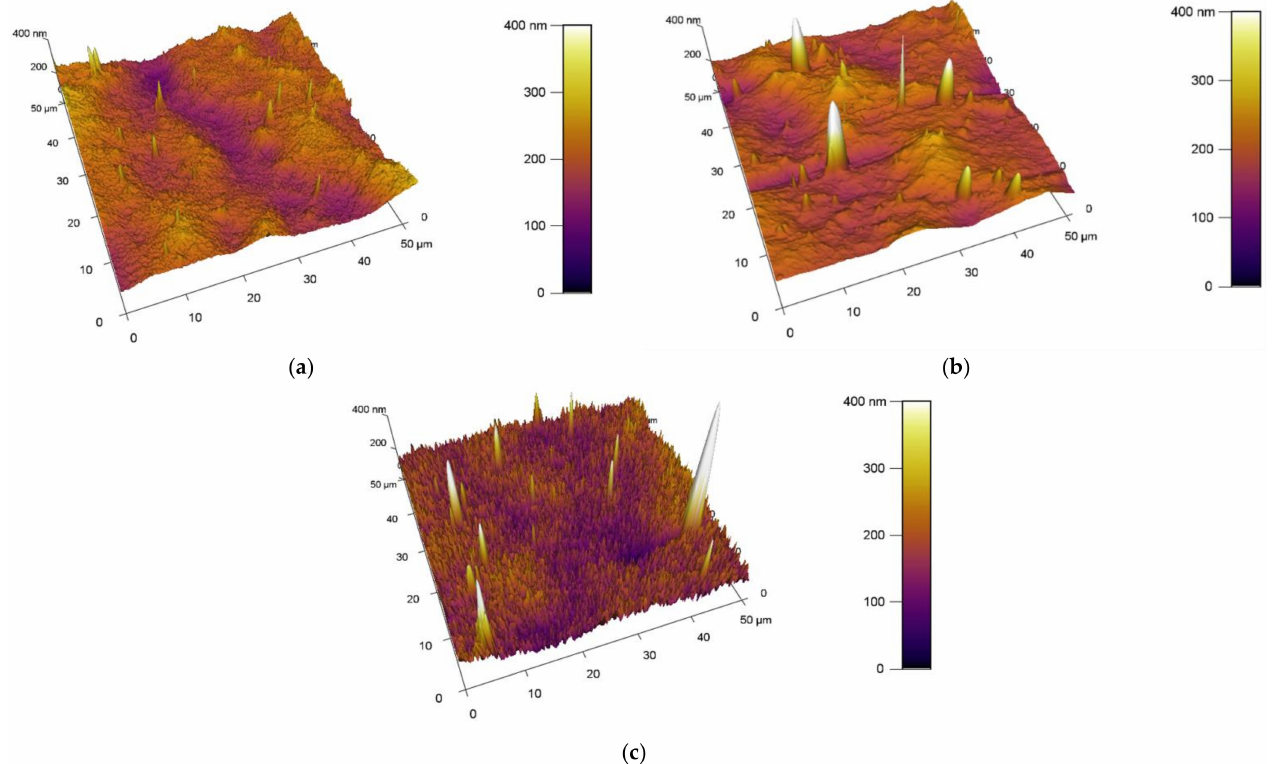
Figure 9. AFM images of plasma modified (modification type 1: MONO) surfaces of PVC. Exposure types I ( a ), II ( b ) and III ( c